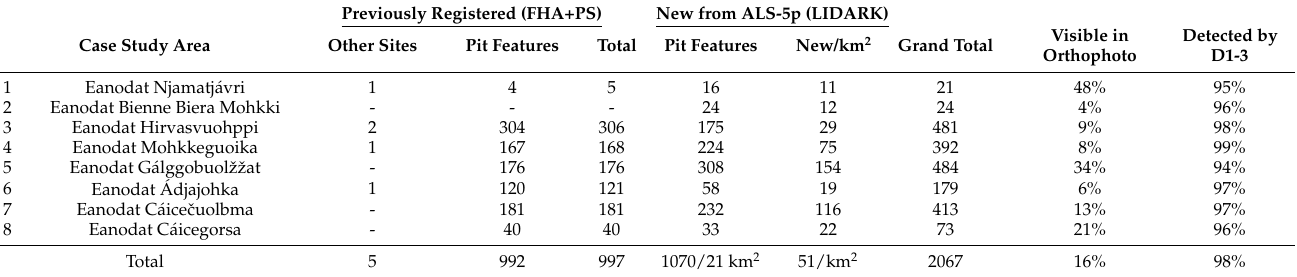
Table 4. Number of archaeological features in each case study area before and after the exploratory analysis of ALS-5p data (numbers of the previously registered sites based on the Finnish Heritage Agency (FHA) and the Project Sturmbock (PS) data; “Other sites” are Stone Age and Iron Age habitation and find localities), and the percentage of total features that are visible in the orthophotos (both natural and false-color), and the percentage of how many were detected by the used U-Net detectors